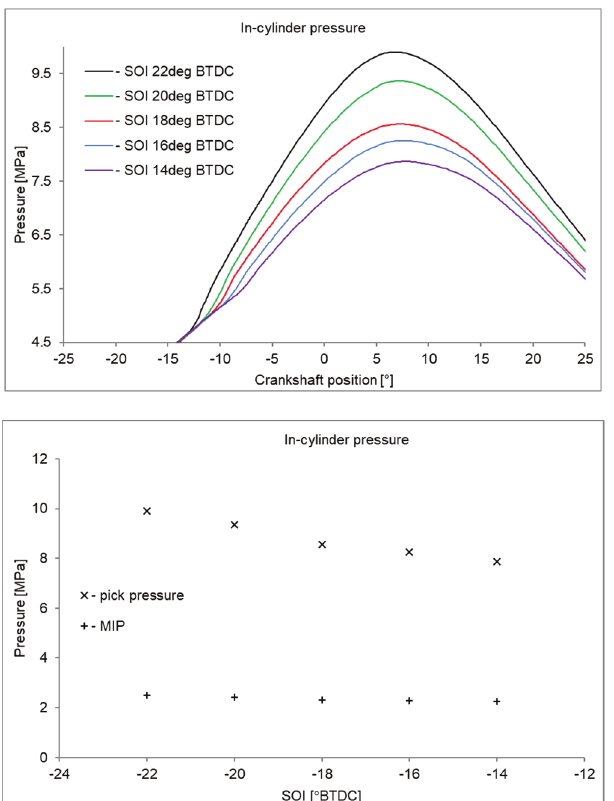
Fig. 7. Pressure of combustion